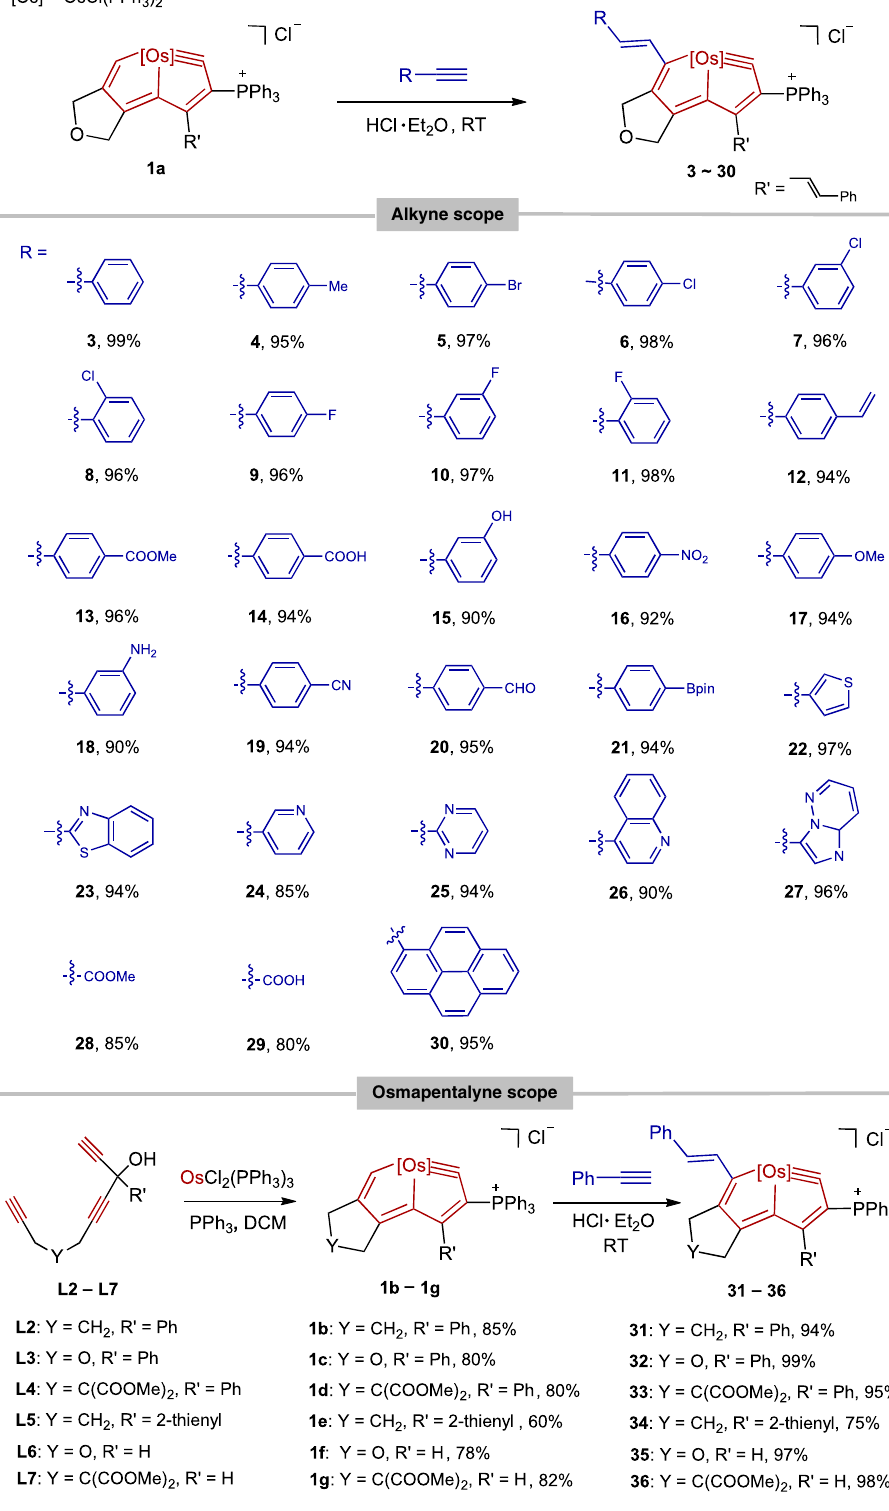
Figs. 8 – 10), and the light response of the device using 30 as ETL was strengthened, thus the J sc was enhanced correspondingly.